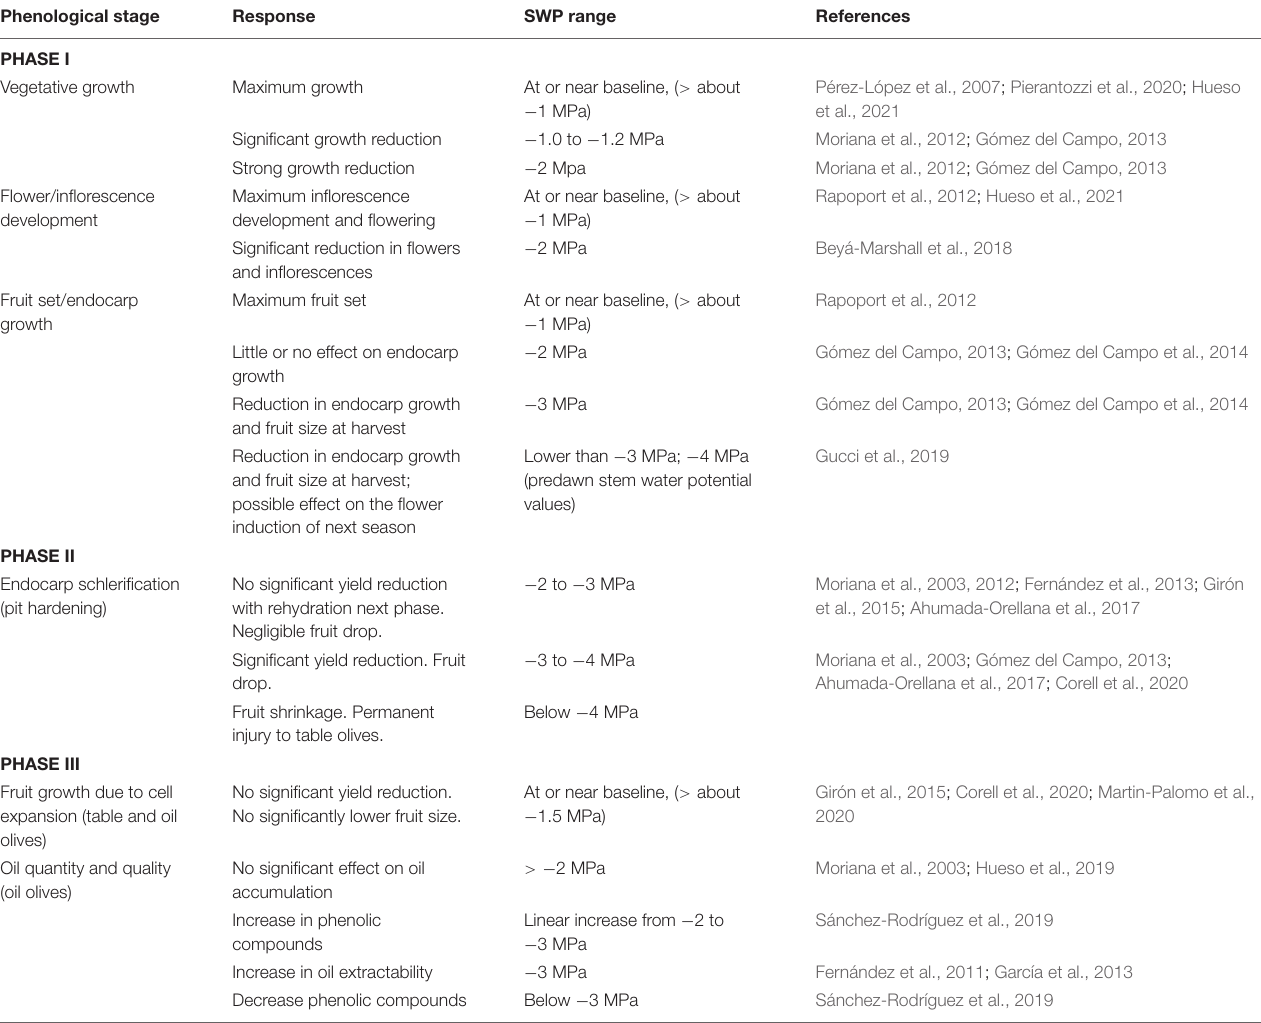
TABLE 4 | Guidelines for the use of SWP for deficit irrigation management in olive